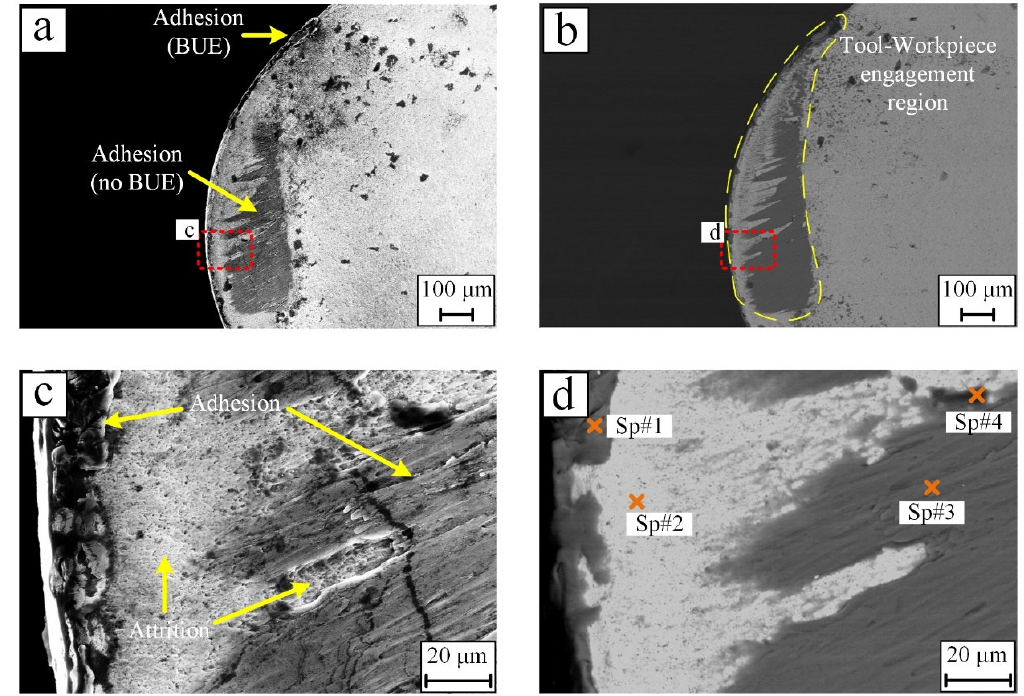
Figure 18. The worn inserts after machining SLMed titanium tubes at a cutting depth of 0.5 mm: ( a ) secondary electron image showing the overview of the worn area, ( b ) backscatter electron image highlighting tool ‐ workpiece contact area, ( c ) enlarged area of shown in ( a ), and ( d ) enlarged area shown in ( b ).